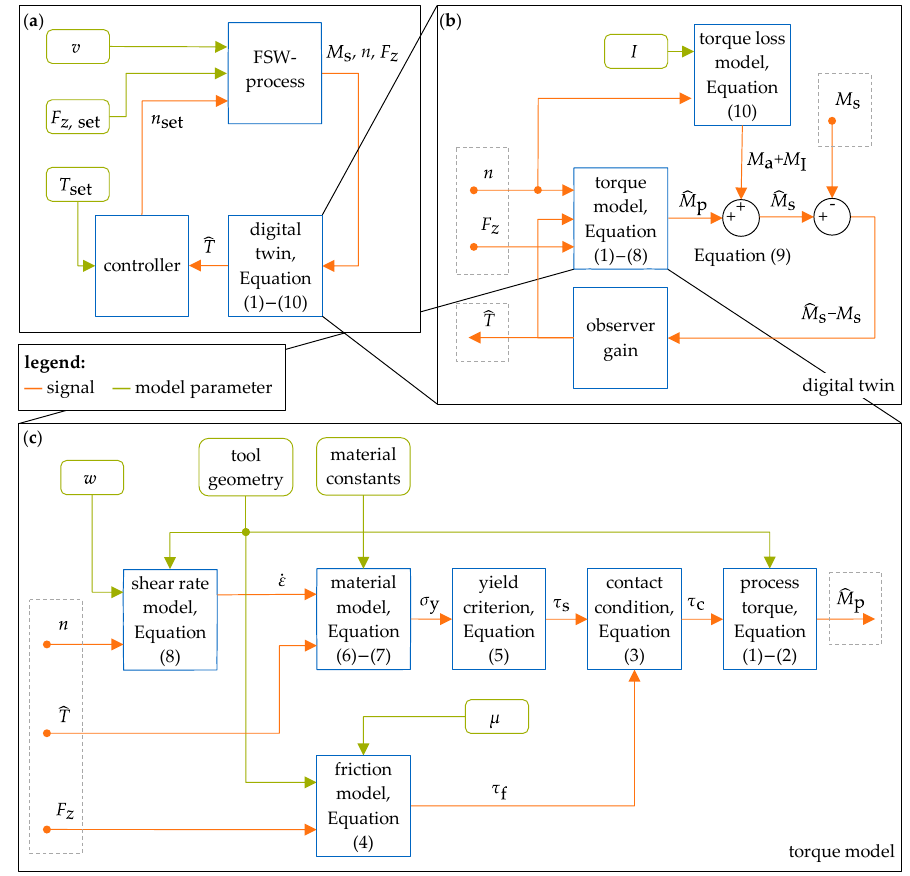
Figure 1. ( a ) Complete control structure with ( b ) the digital twin and ( c ) the torque model.